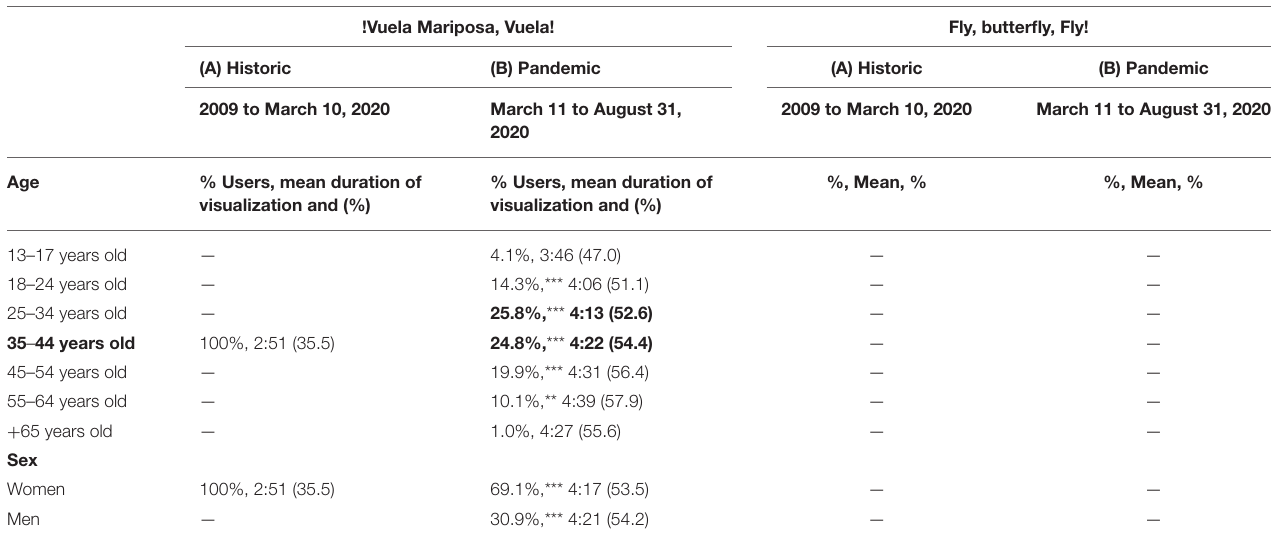
TABLE 2 | Comparative analysis on the use of the children’s story on cycle of life, death, and grief—age and